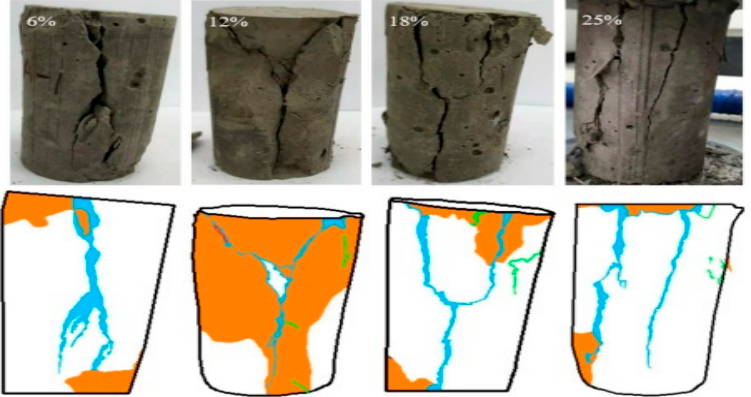
Figure 6. Failure crack evolution characteristics of CSTB under uniaxial loading [32].